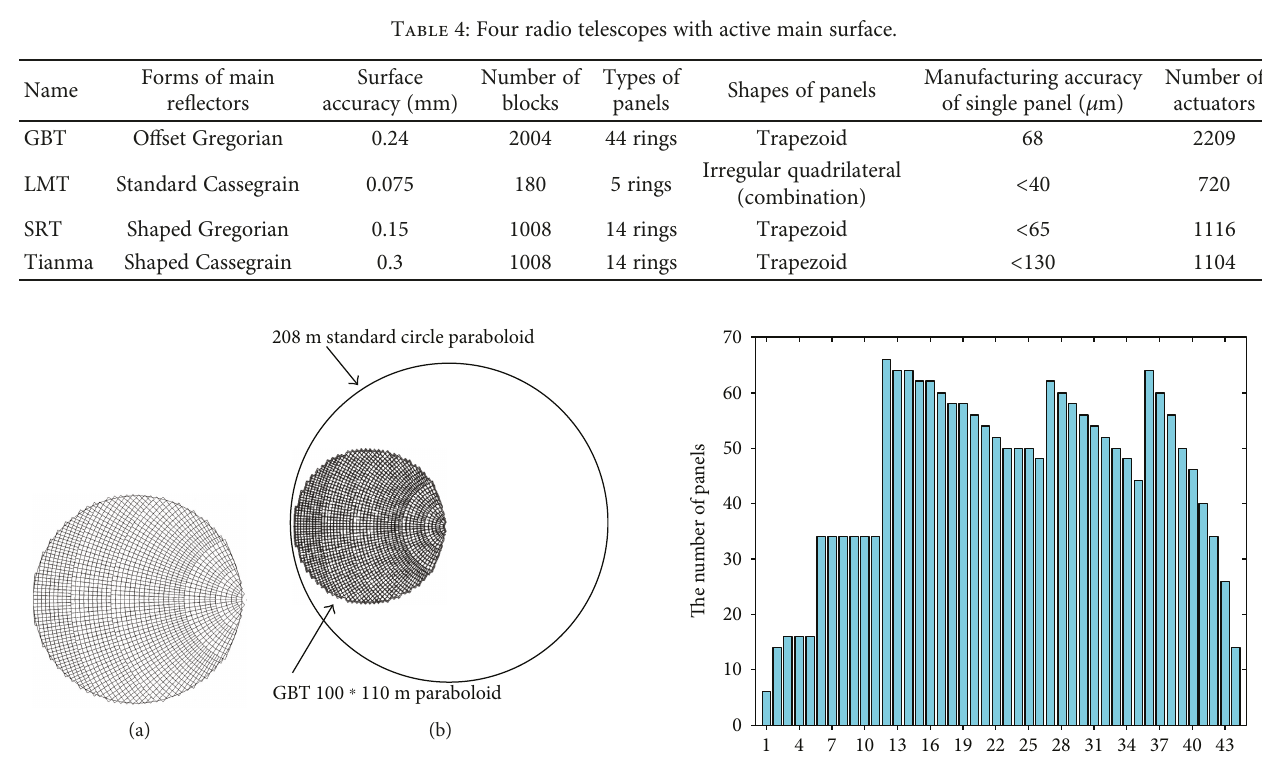
Figure 3: Segment design of GBT main surface [60]. (a) Main surface of GBT and (b) parent paraboloid of GBT.